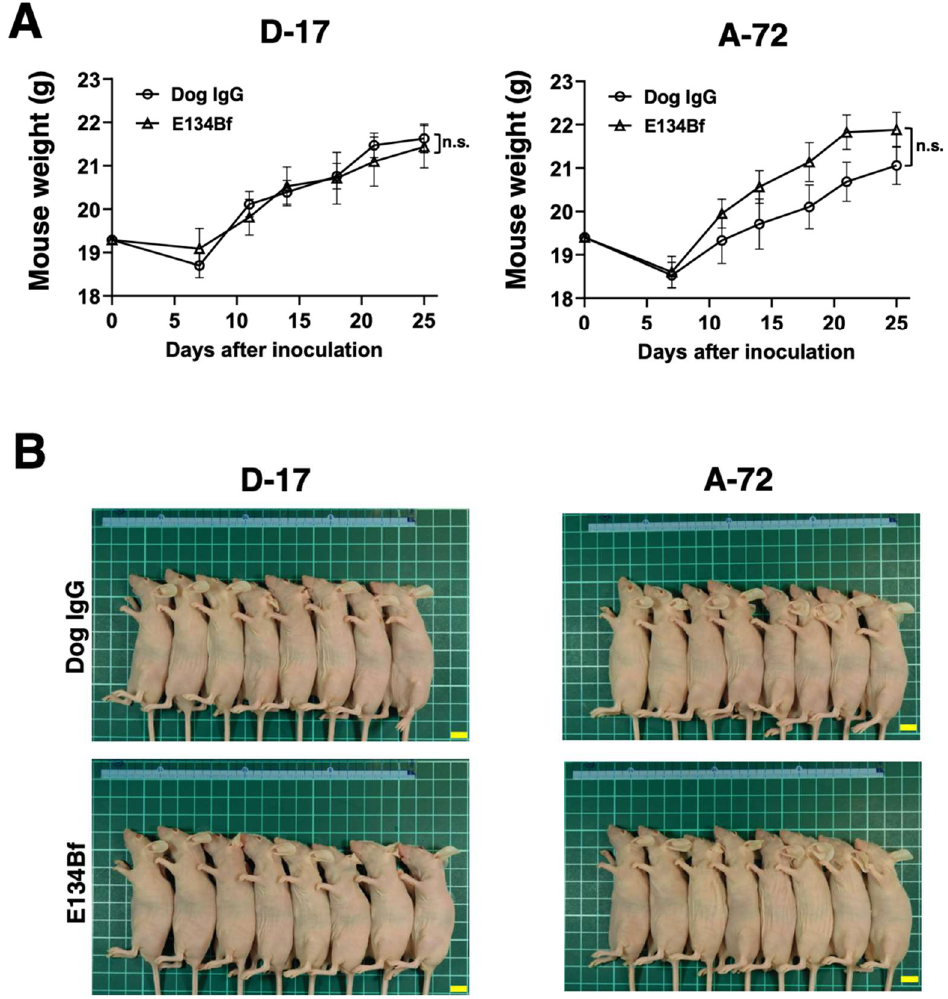
Figure 7. Body weights and appearance of the mice implanted with the D-17 and A-72 xenografts. ( A ) Body weights of mice implanted with the D-17 and A-72 xenografts were recorded on days 7, 11, 14, 18, 21, and 25 (n.s.: not significant). ( B ) Body appearance of the D-17 and A-72 xenograft mice on day 25. Scale bar, 1 cm. n.s., not significant.